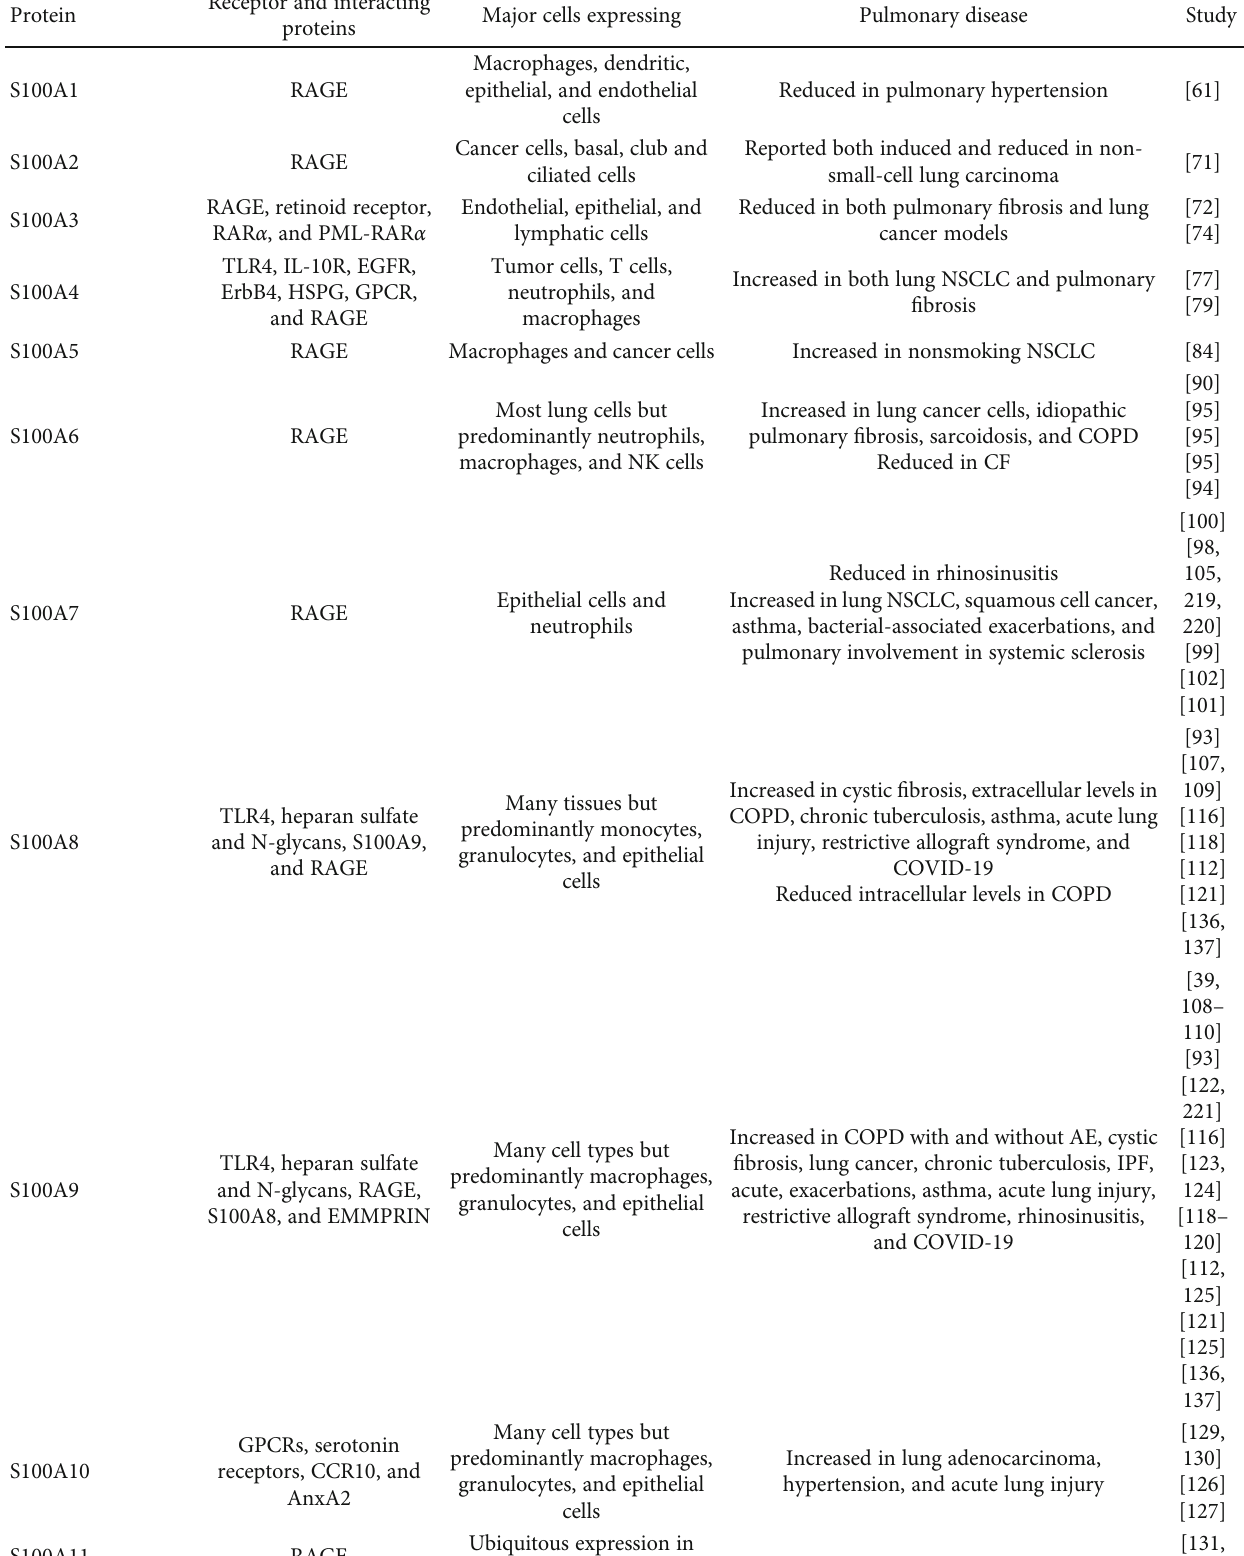
Table 1: S100 proteins involved in pulmonary